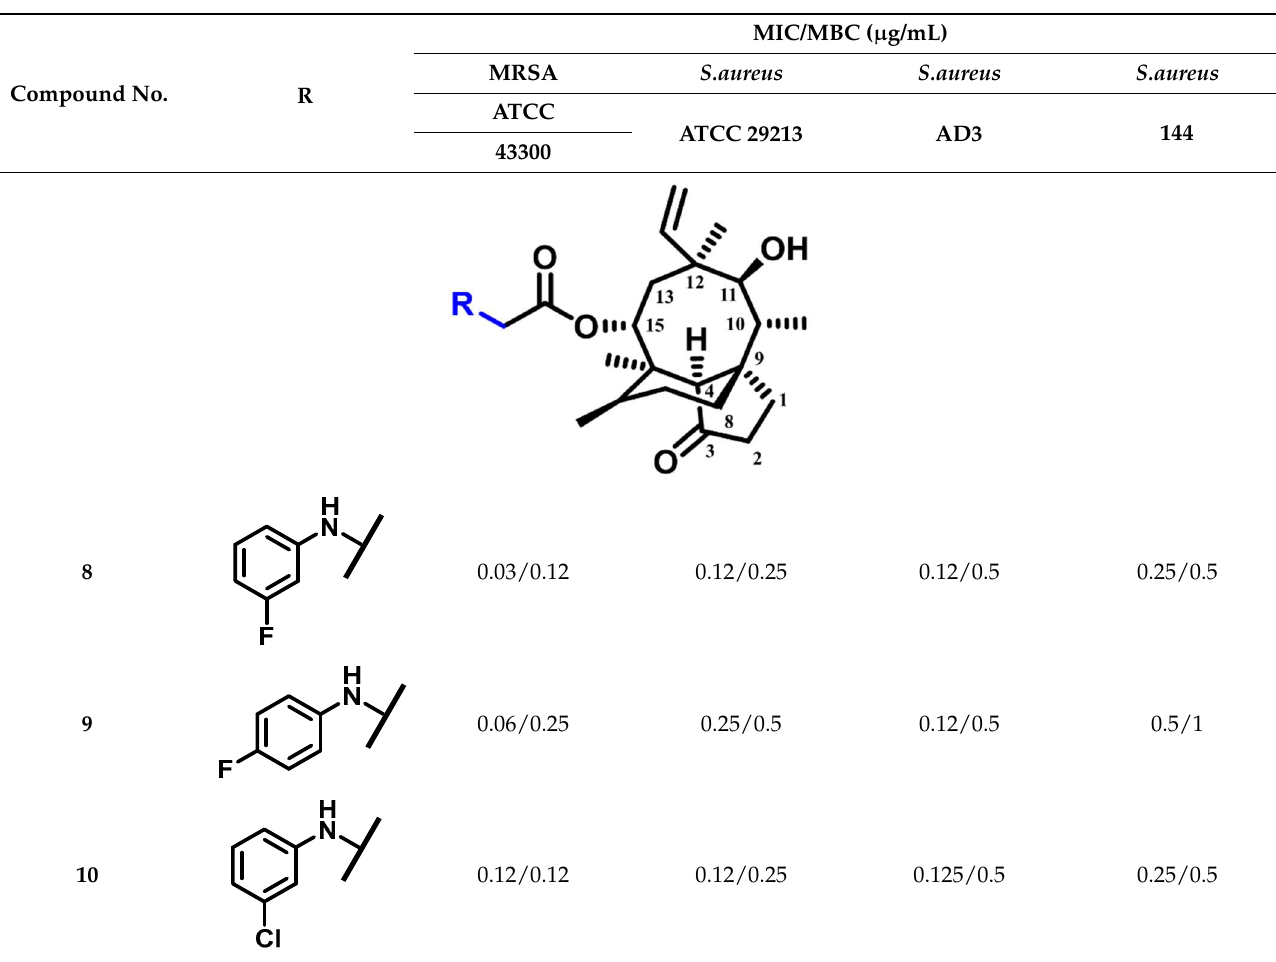
Table 1. MIC and MBC (μg/mL) values of compounds 8 – 30 , tiamulin against S. aureus (ATCC